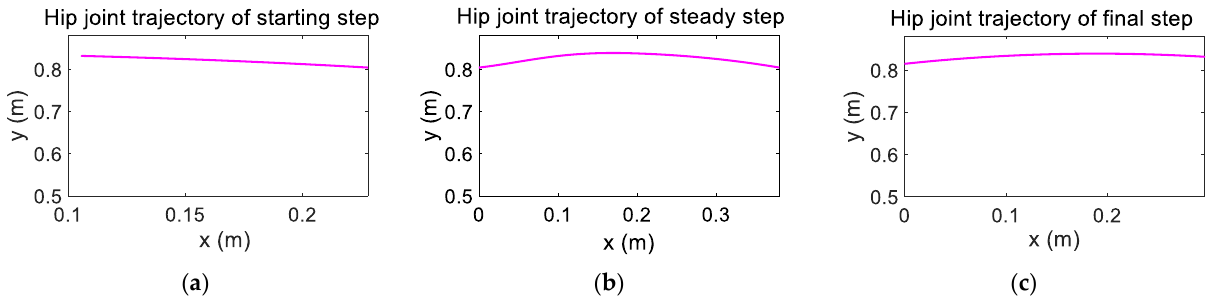
Figure 3. The motion trajectory of the hip joint in the starting ( a ), steady ( b ), and final ( c ) steps.